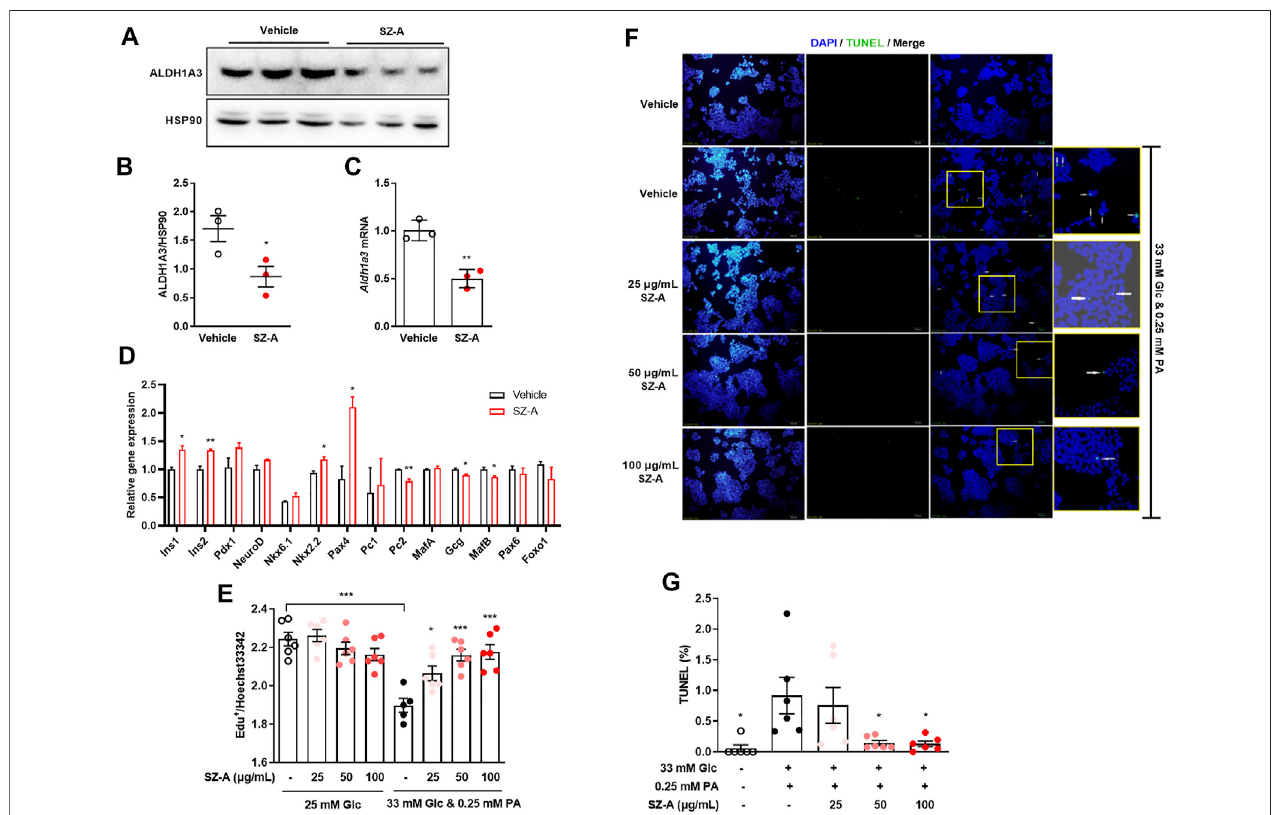
FIGURE 4 | SZ-A prevented β -cell dedifferentiation in type 2 diabetic KKA y mouse islets, and apoptosis in high glucose- and PA-treated MIN6 cells. (A,B) ALDH1A3 expression levels, (C) Aldh1a3 mRNA levels and (D) β -cell and α -cell relative gene expression levels in KKA y mouse islets treated with 100 μ g/ml SZ-A or vehicle for 24 h ( n = 3 replicates in each group). All data are expressed as the mean ± SEM. * p < 0.05, ** p < 0.01, vs. the vehicle group. (E) MIN6 cells were treated with high glucose and PA and 25, 50, or 100 μ g/ml SZ-A or vehicle for 24 h. The EdU assay was performed in MIN6 cells ( n = 6 replicates per group). (F,G) MIN6 cells weretreatedunderthesameconditionsfor72 h. (F) NucleiwerelabeledwithDAPI(blue),andapoptoticbodiesweremarkedbyTUNEL(green). (G) TheratioofTUNEL- positive cells/cell nucleus. All data are expressed as the mean ± SEM ( n = 5 – 6 replicates per group). * p < 0.05, *** p < 0.001, vs. the Glc + PA group.